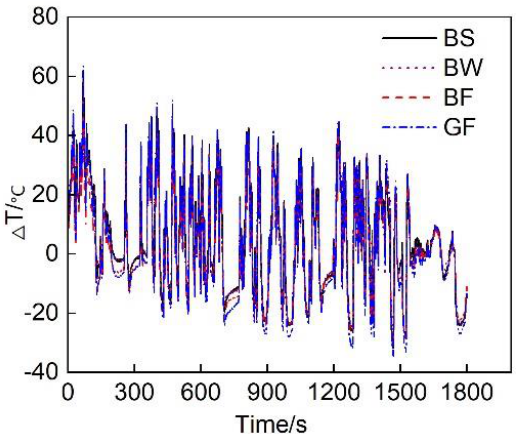
Figure 5. Temperature decrease Δ T in the exhaust pipes with different covering schemes over time.